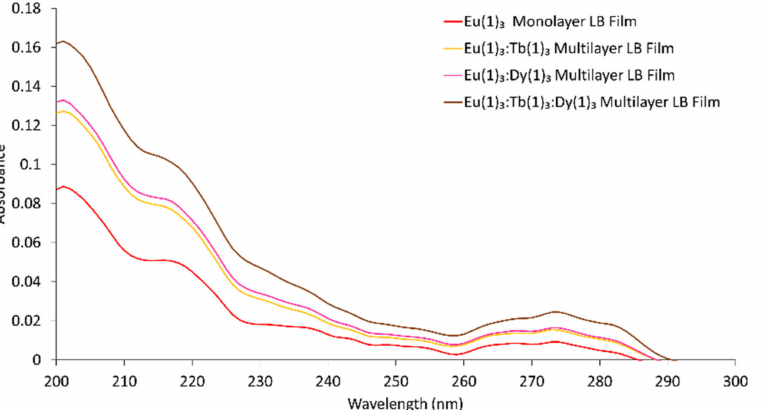
Figure 2. UV-visible absorption of Ln( 1 ) 3 LB films (where Ln = Eu 3+ , Tb 3+, and Dy 3 ) showing the absorbance enhancement observed from increasing layers on the LB